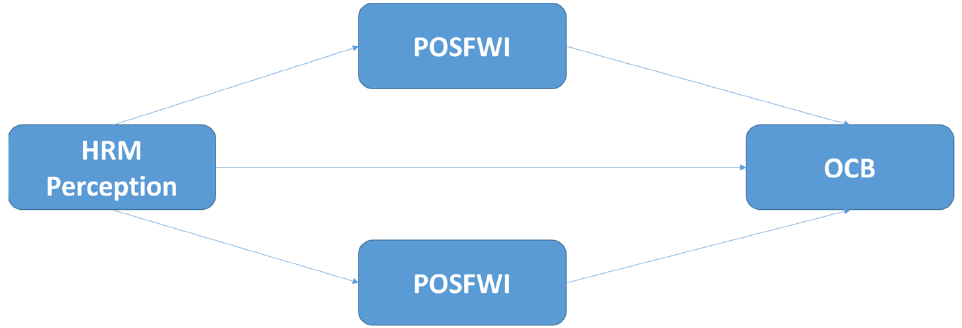
Figure 1. Theoretical mediational model examining the direct and indirect effects of HRM Perception on OCB, mediated by Positive Work-To-Family and Family-To-Work Spillover.